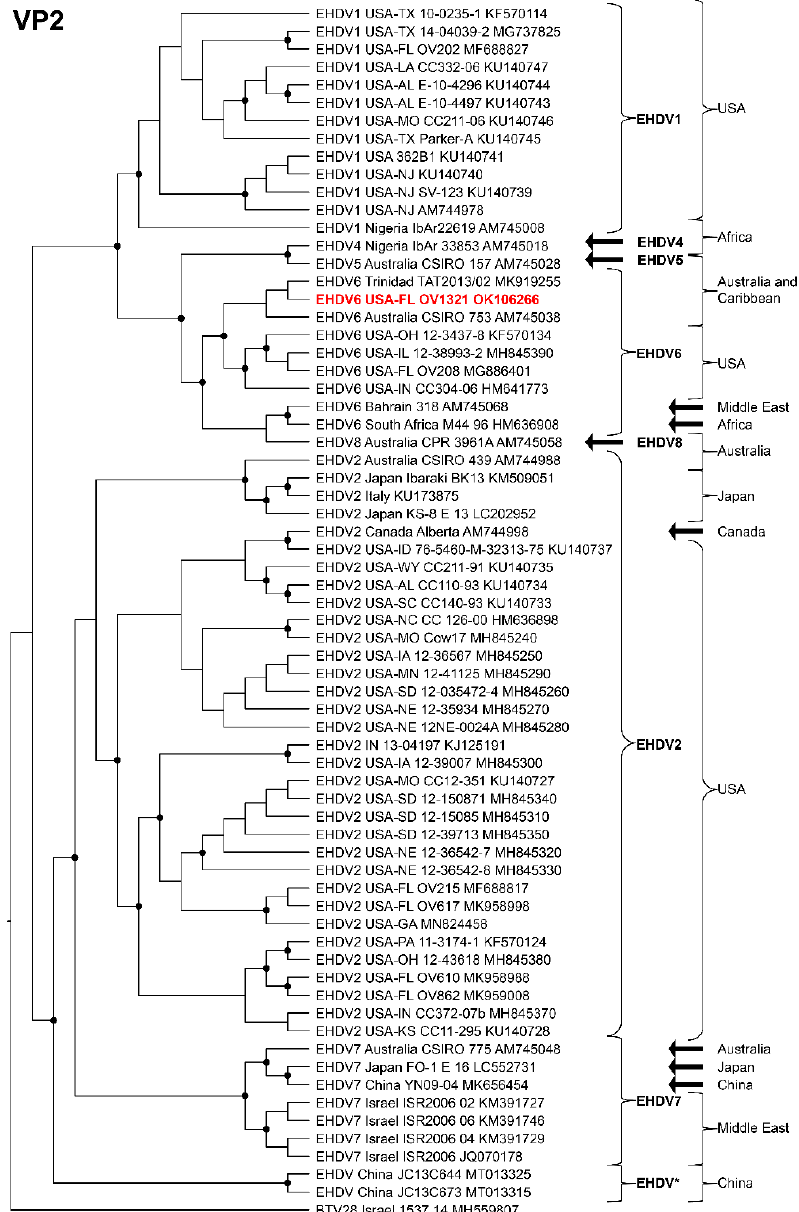
Figure 7. Maximum Likelihood cladogram depicting the relationships of the U.S. novel reassortant EHDV-6 strain isolated from a white-tailed deer (OV1321) to 66 other EHDV strains. The tree was generated from the nucleotide sequence alignment of the VP2 gene. The included EHDV and BTV strains are indicated by serotype, country, state (for U.S. strains), strain or isolate name, and GenBank accession no. Nodes with black circles are supported by bootstrap values ≥ 80%. The tree was rooted with the BTV-28 strain. Additional metadata for each virus in the tree are provided in Supplemental Table S1.